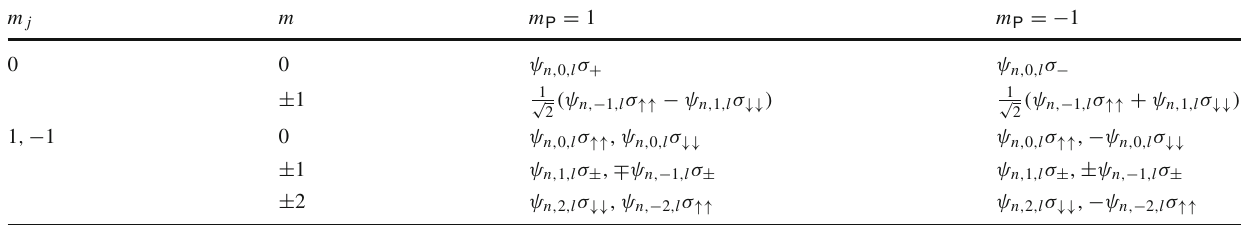
Table 1 Basis states ψ nml σ s ¯ s categorized by the mirror parity m P according to Eq. (17) m j m m P = 1